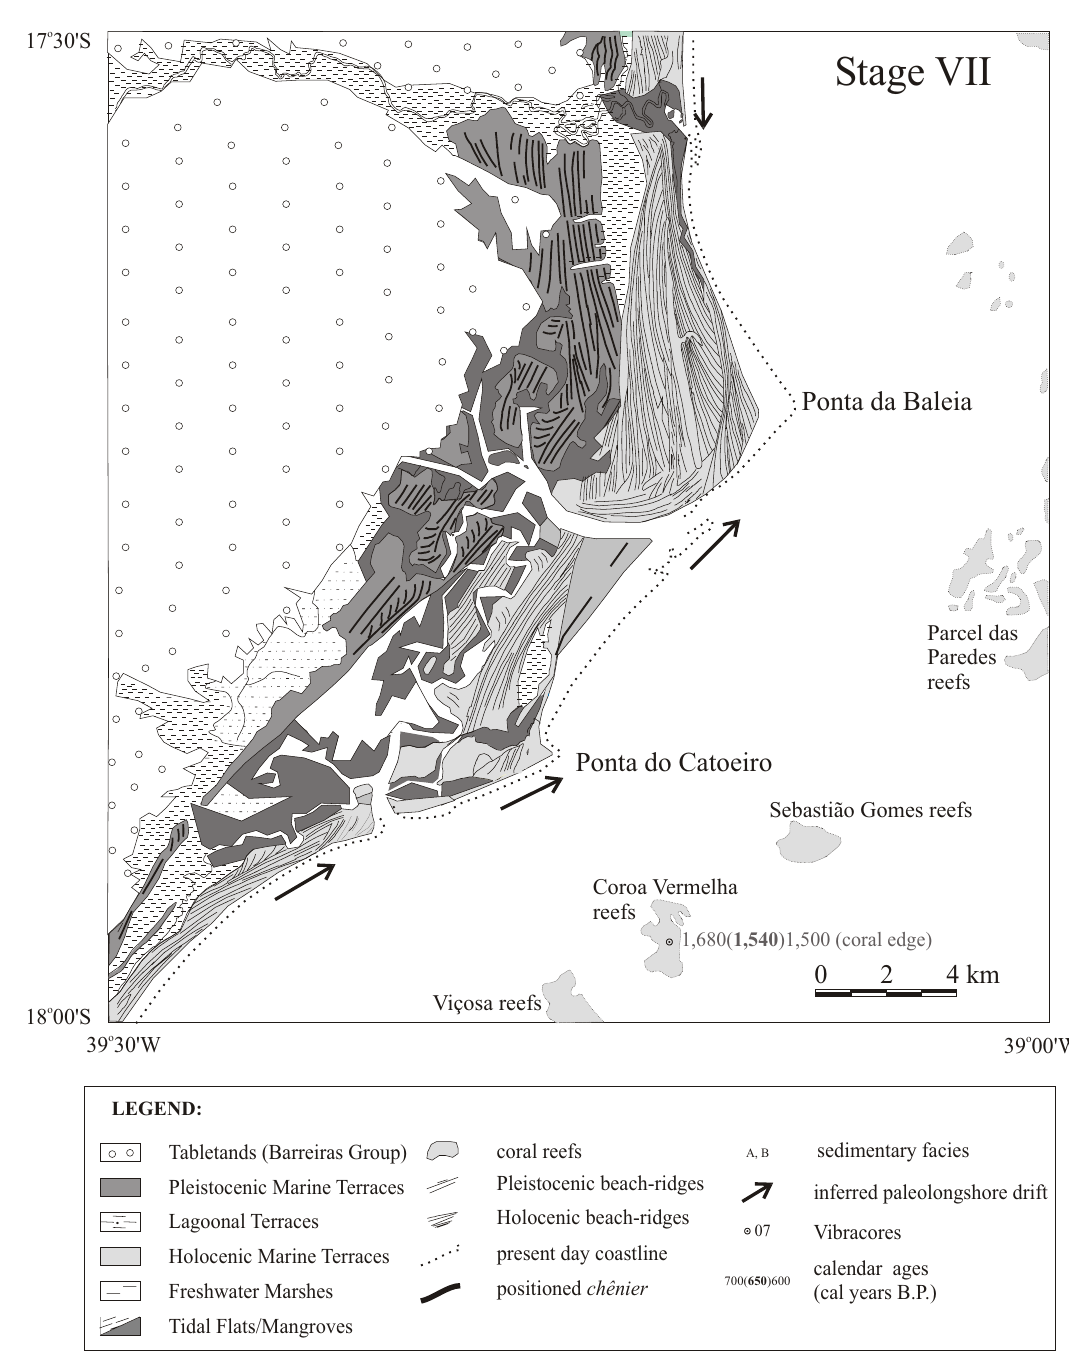
Fig. 15 – Quaternary evolution of the Caravelas strandplain: Stage VII – Renewed coastline